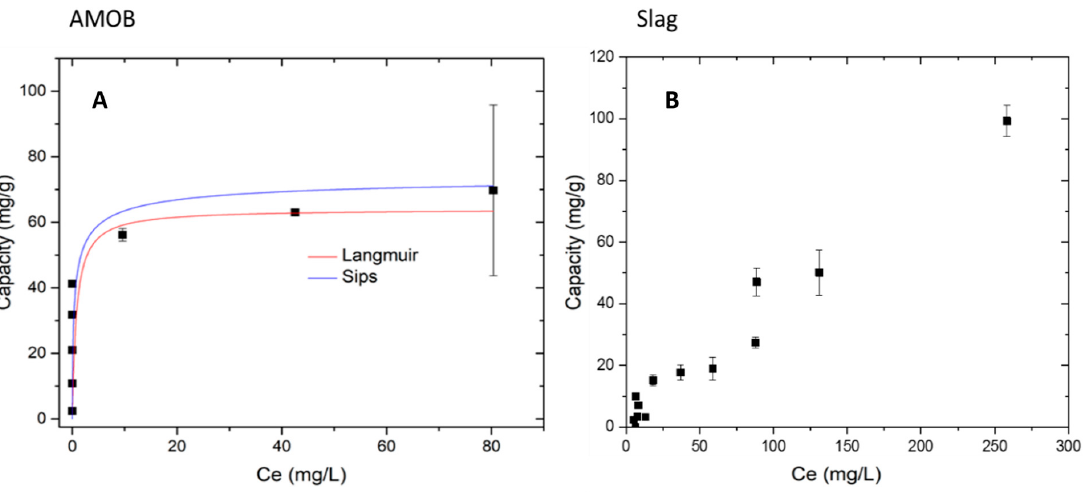
Figure 8. Langmuir and Sips isotherms modeled for AMOB and slag adsorption processes. ( A ) Langmuir isotherm for AMOB capacity 69.7 mg/g, ( B ) Slag observed capacity 109.7 mg/g, adsorbent concentration = 0.002 g/mL; shaking time 24 h].